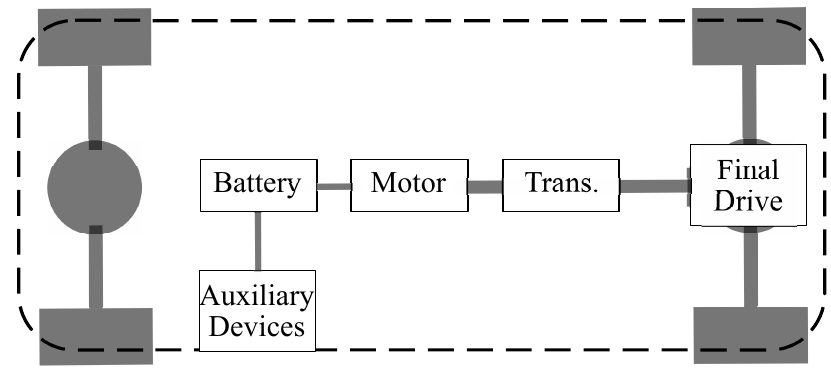
Figure 1. Electric Vehicle (EV) Configuration [38].